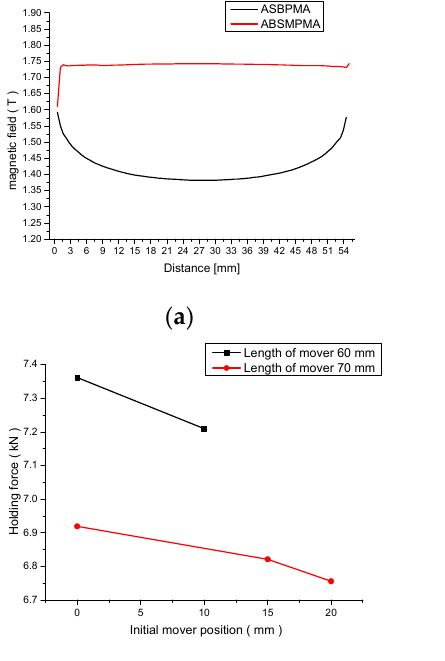
Holding force of ABSMPMA comparison line of holding force of ASBPMA